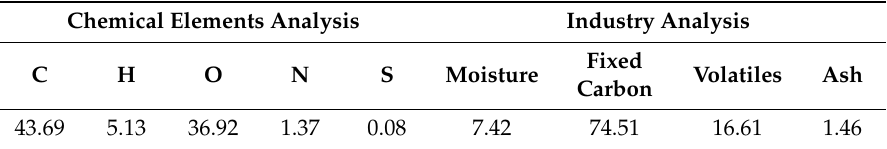
Table 1. Chemical elements and industry analysis results of sawdust (wt.%).